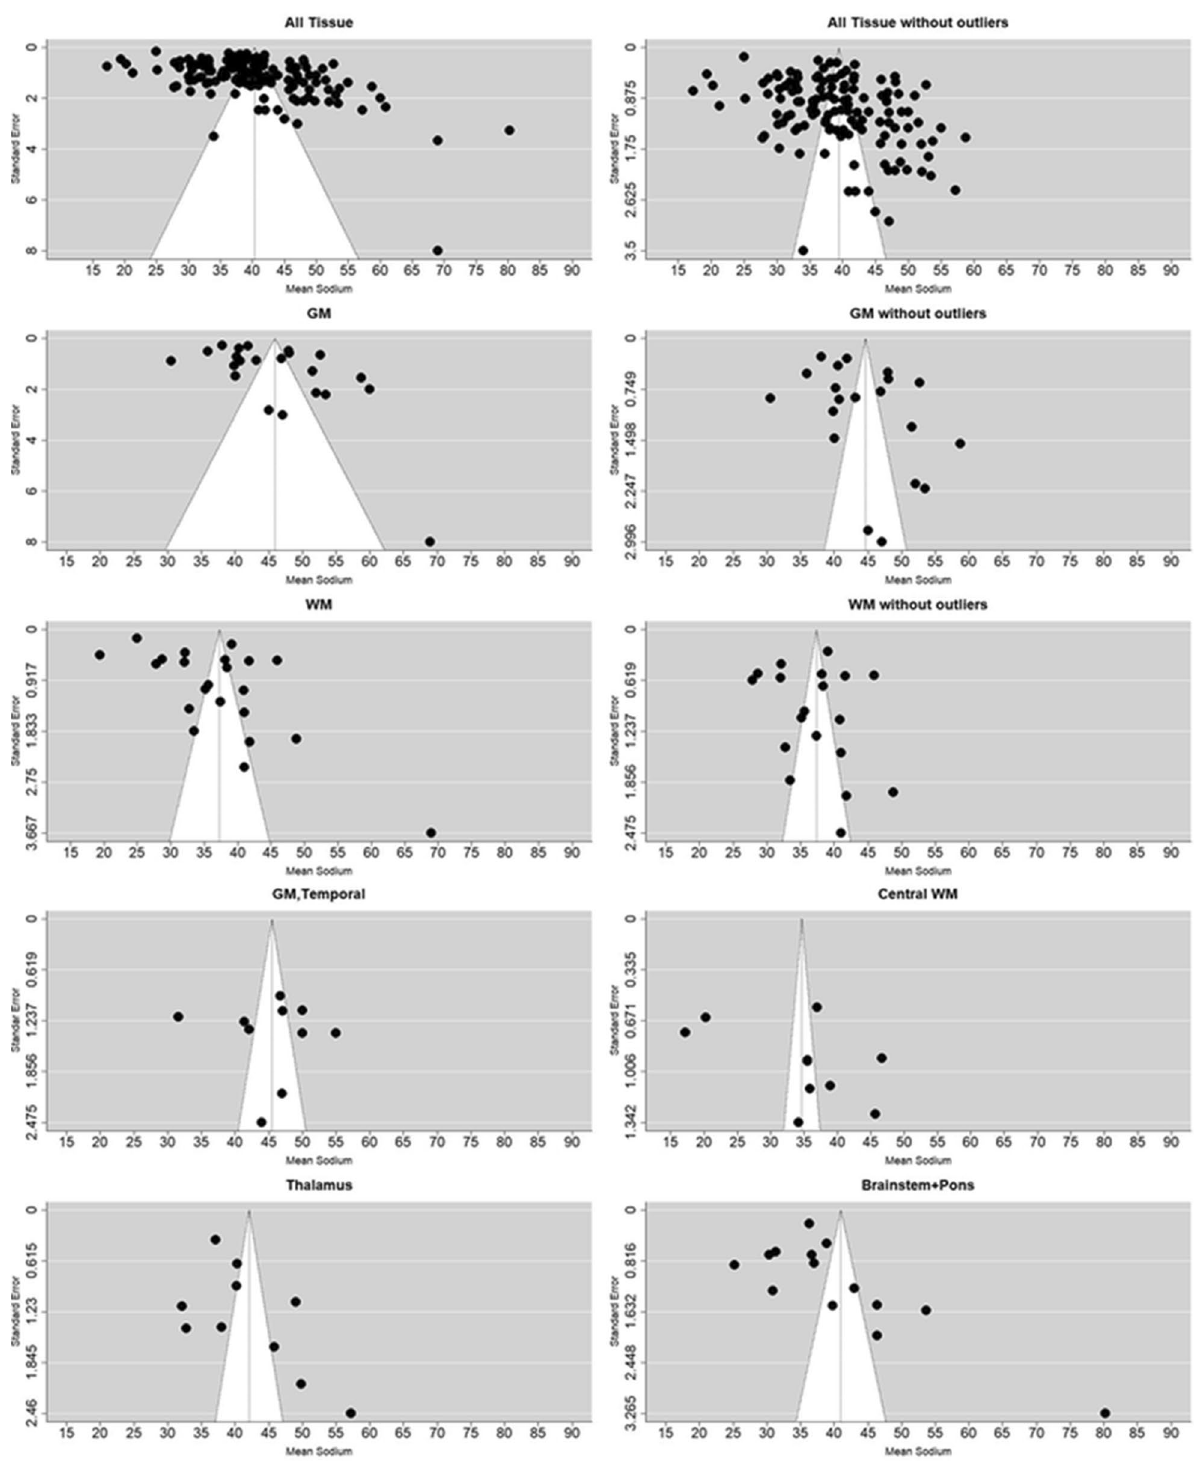
Figure 5. Funnel plots comparing effect sizes (mean TSC) with their precision (standard error): All tissues (141 effect sizes) and with outliers removed (136 effect sizes); GM effect sizes with (22, left) and without outliers (20, right); WM effect sizes with (22, left) and without outliers (19, right); GM, Temporal; Thalamus; Brainstem + Pons, and Central WM. Images created in R 74,84